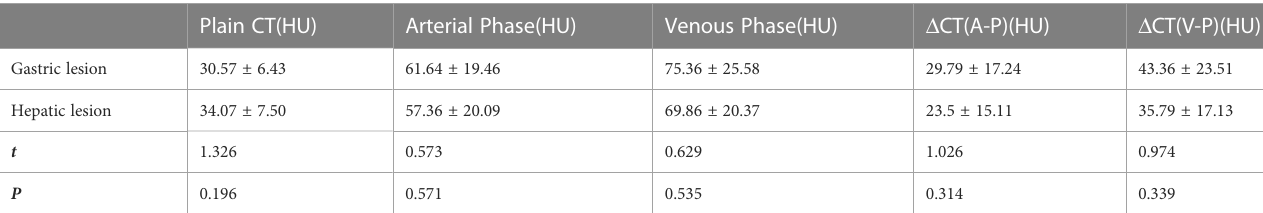
TABLE 3 CT value comparison between hepatic metastasis lesions and primary gastric lesions in the hepatic metastasis group. Plain CT(HU)